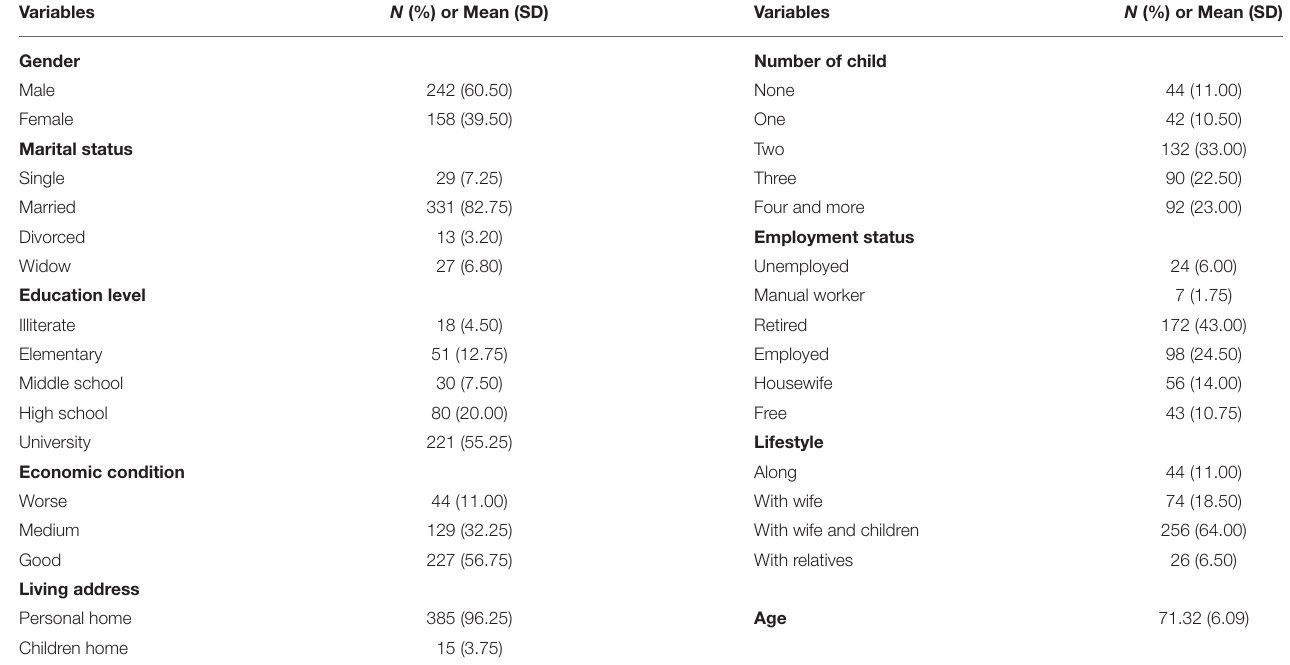
TABLE 1 | Characteristics of the participants.